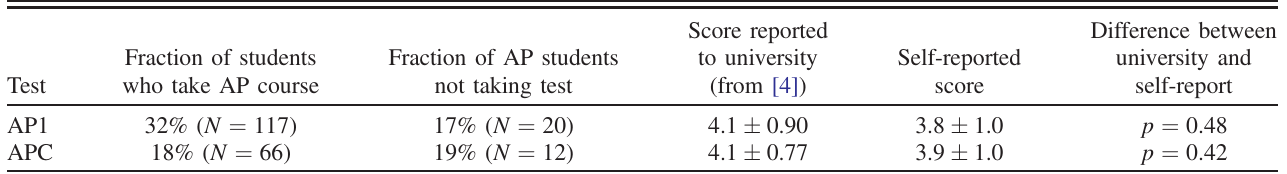
TABLE I. Data on how many students take AP1 and APC, what fraction of those students do not take the AP exam, and average AP exam scores and standard deviations for both exams.